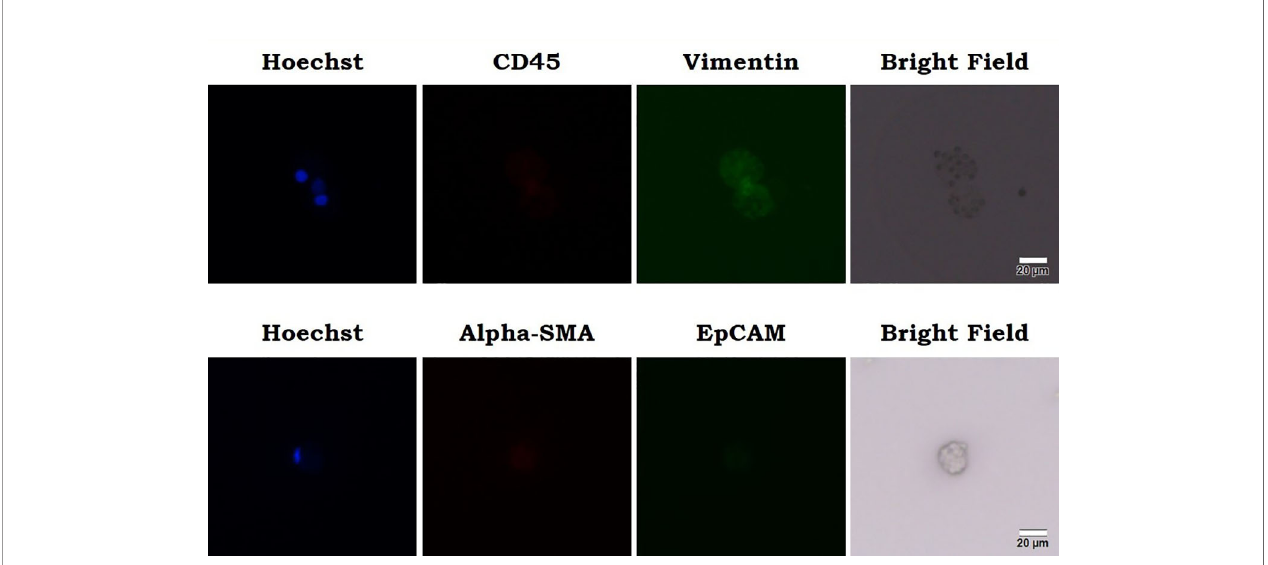
FIGURE 5 | Outgrowth cellular organoids were observed and cells were stained positive for vimentin and negative for CD45 or EpCAM. Cellular sensitivity to cytotoxics was measured with relative ATP abundance comparing to cells treated with mock